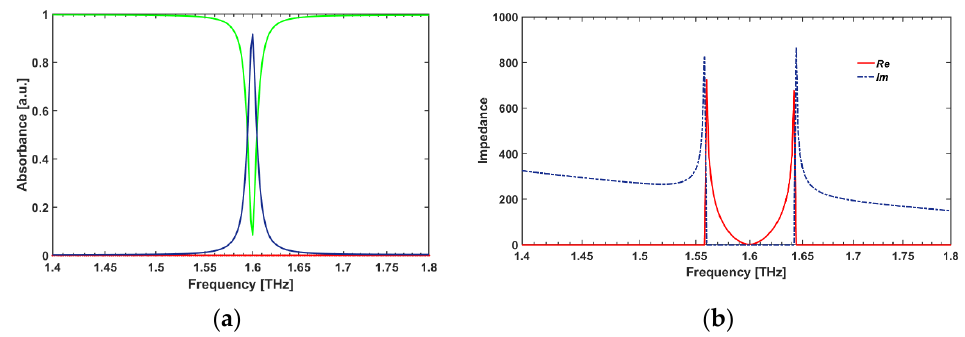
Figure 3. ( a ) The absorbance (blue-line), and the reflectance (green line) spectral responses, and ( b ) the complex effective impedance of unit cell A as a function of frequency. 192